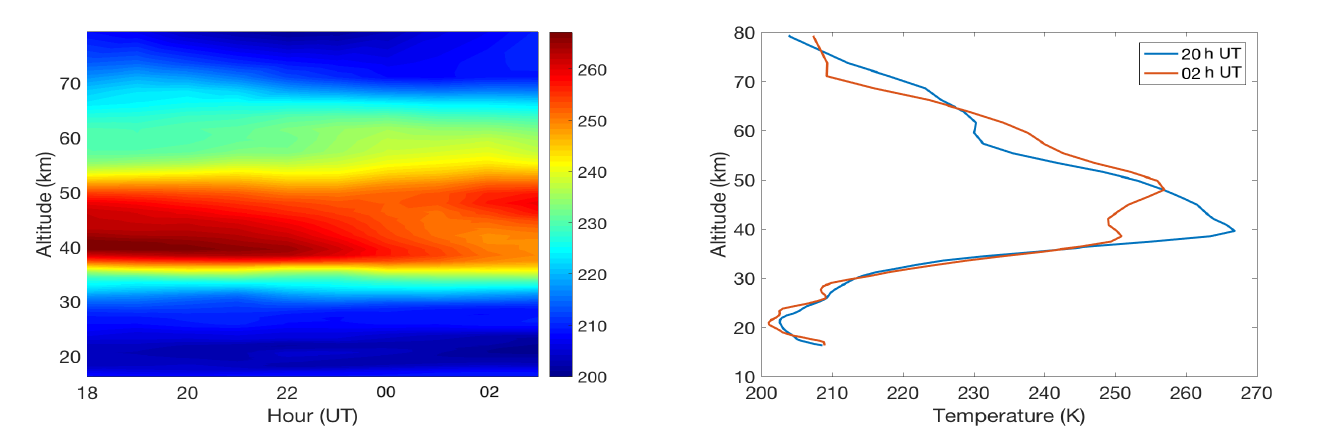
Figure 10. Left : 2D temperature profile during the night of 12 December 2017 from the ERA5 data. Right : Temperature profile at 20 h UT in blue and 02 h UT in red from the ERA5